Question: How would you classify this visualization?
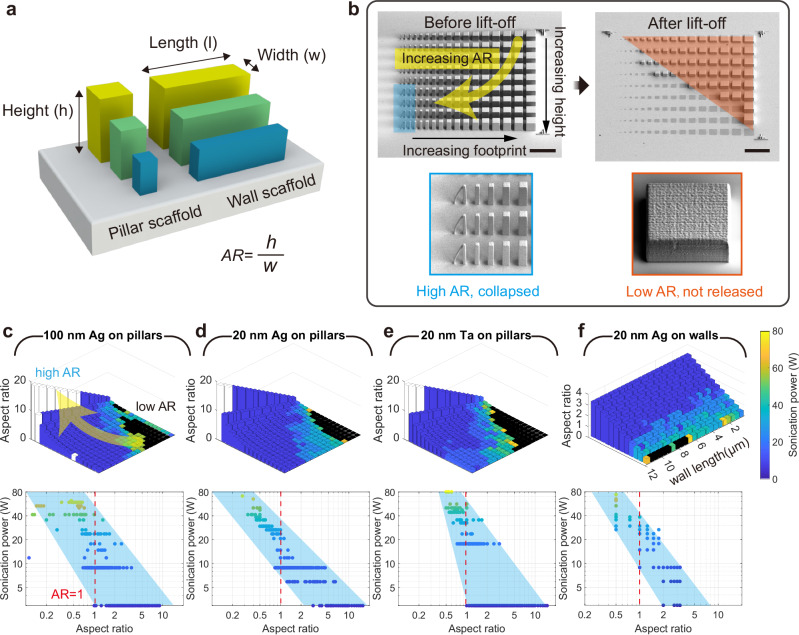
Answer: scatter